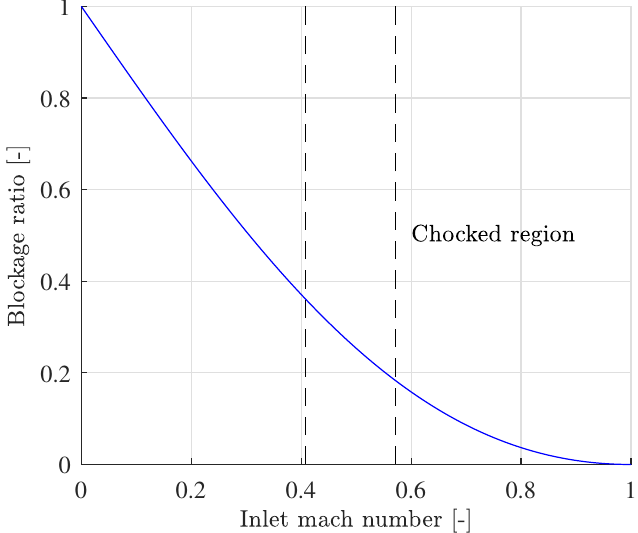
Figure 7. Kantrowitz limit as a function of the inlet Mach of the domain M ref or the blockage ratio β . Speeds of 500 km/h and 700 km/h, computed using a static temperature of 288.15 K, are marked with dashed